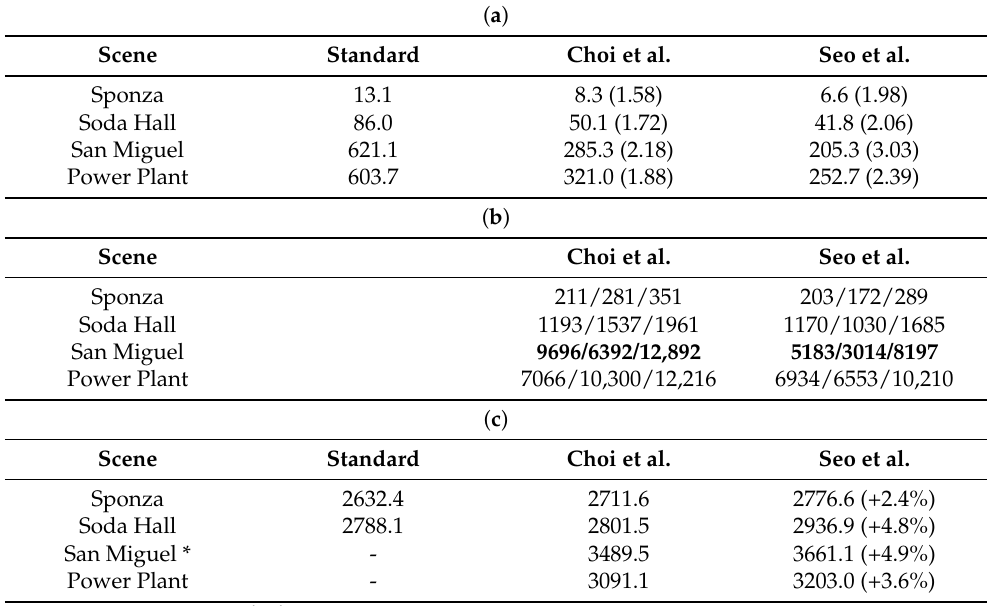
Table 5. Performances of three kd-tree construction methods. The effectiveness of Seo et al.’s method [7], which is used in the proposed mobile distributed ray tracing system, is compared on the mobile platform to the two previous methods: “standard” [21,22] and “Choi et al.” [29]. ( a ) Size of kd- trees (unit: MB). The figures in parentheses represent the respective compression ratios with respect to the sizes of the “standard” kd-trees. ( b ) Number of kd-tree nodes (unit: thousand). Each triplet of numbers reveals the frequencies of the inner nodes without triangle references, the inner nodes with triangle references and the leaf nodes in the kd-tree. The reduction effect is most evident for the San Miguel scene, leading to the greatest kd-tree compression among the four scenes. ( c ) Ray tracing time (unit: ms). The time for rendering an image of 1024 × 1024 pixels was measured on a single LG G5 smartphone. As the original triangular meshes were used without quantization in this test, the San Miguel and Power Plant scenes could not be rendered with the standard kd-trees due to the lack of GPU memory space. The percentages in parentheses show how seriously the slight modification of the kd-tree structure affects the ray tracing speed in comparison to Choi et al.’s